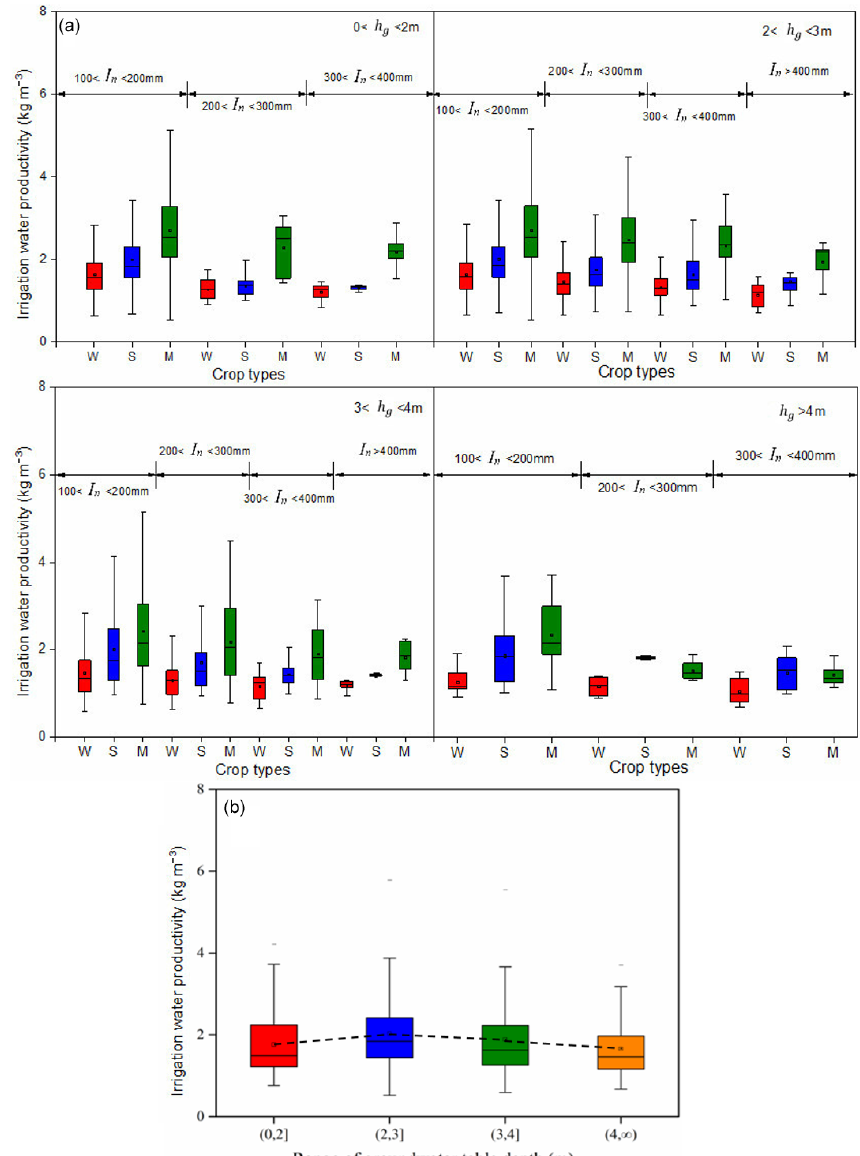
Figure 10. (a) Simulated regional irrigation water productivity under various groundwater table depth ( h g ) conditions with the application of different irrigation water amounts ( I n ); (b) the results of the statistical analysis. In Fig.10a, W, S, and M represent wheat, sunflower, and maize,